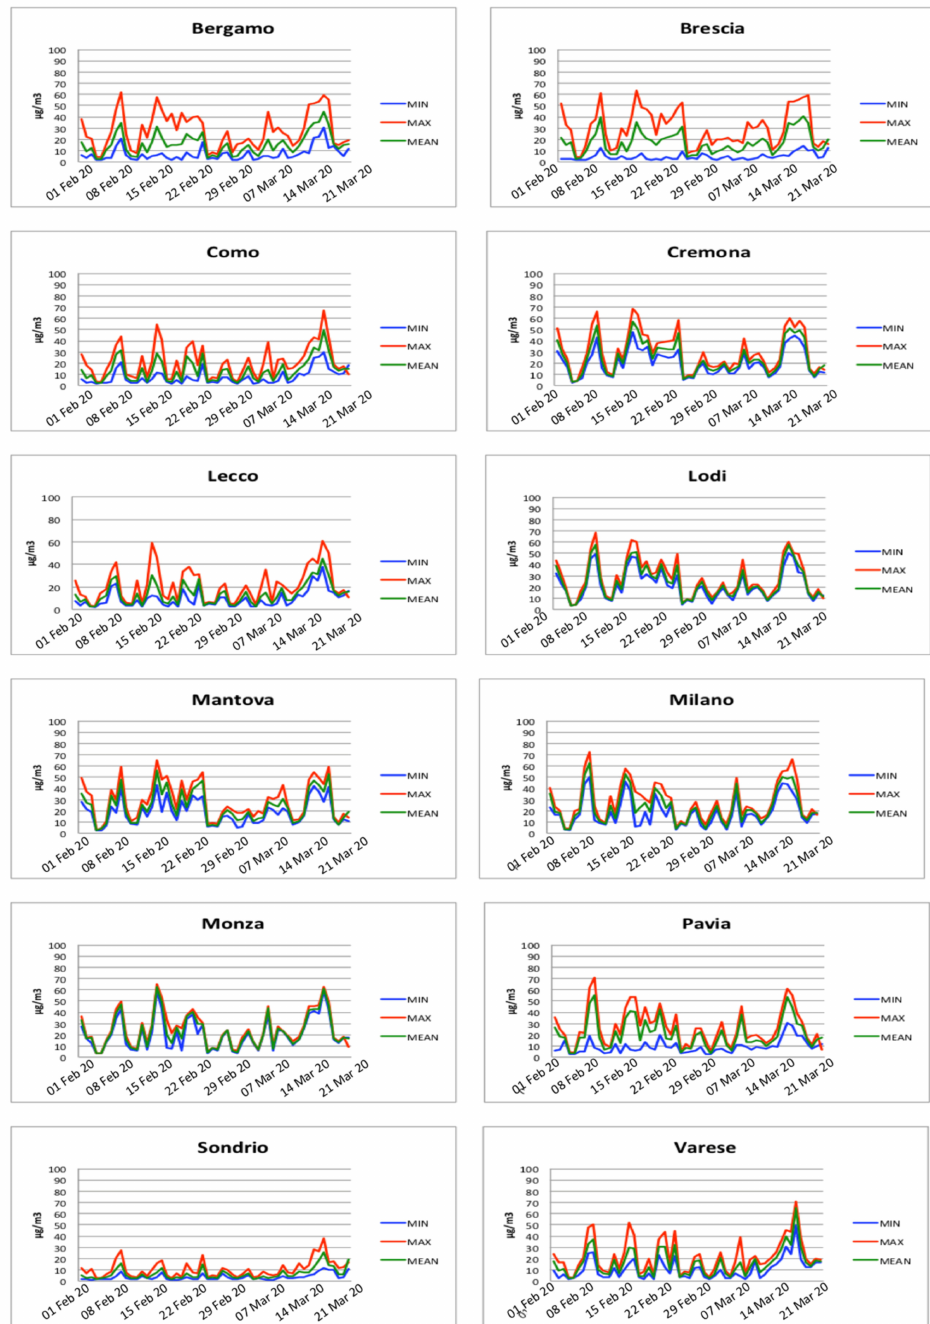
Figure 8. PM10 concentrations measured for each